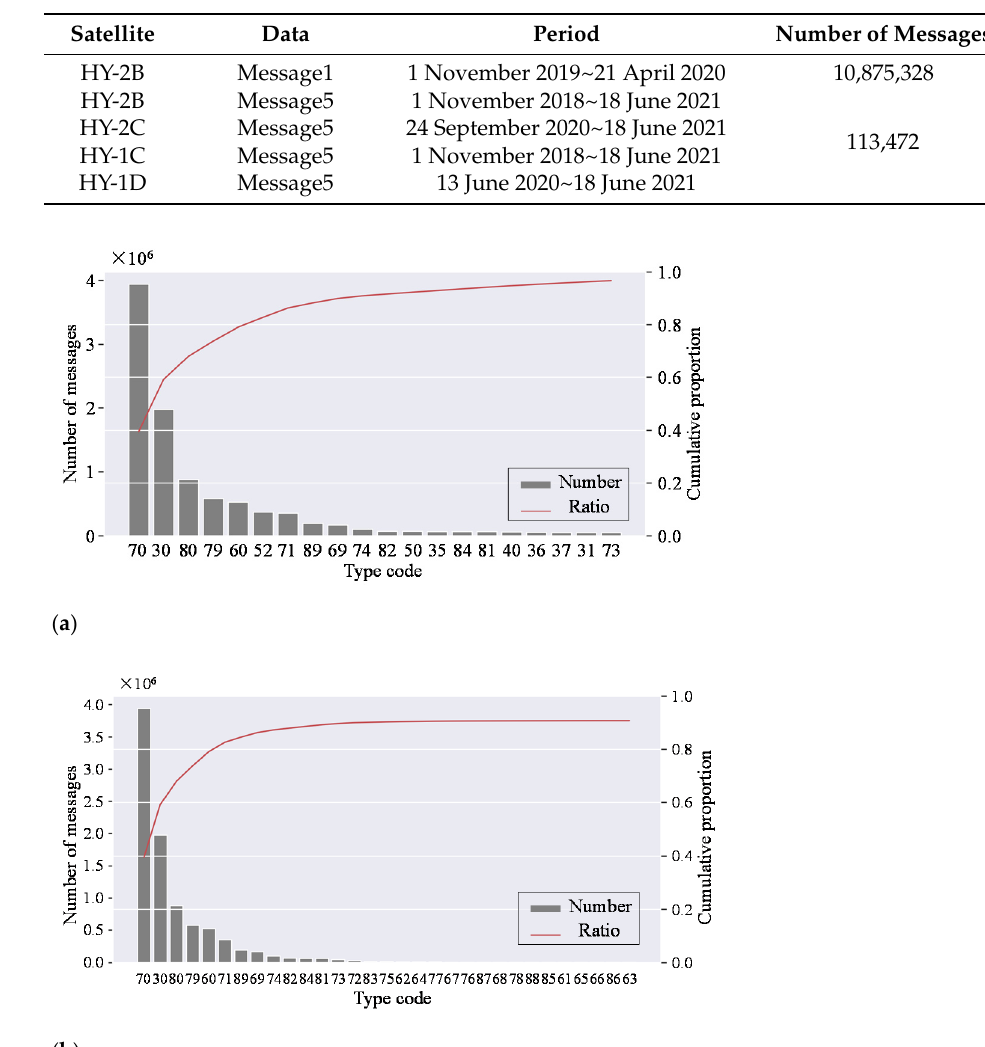
Figure 4. Message1 received by HY-2B. Table 2. Information of message1 and message5.